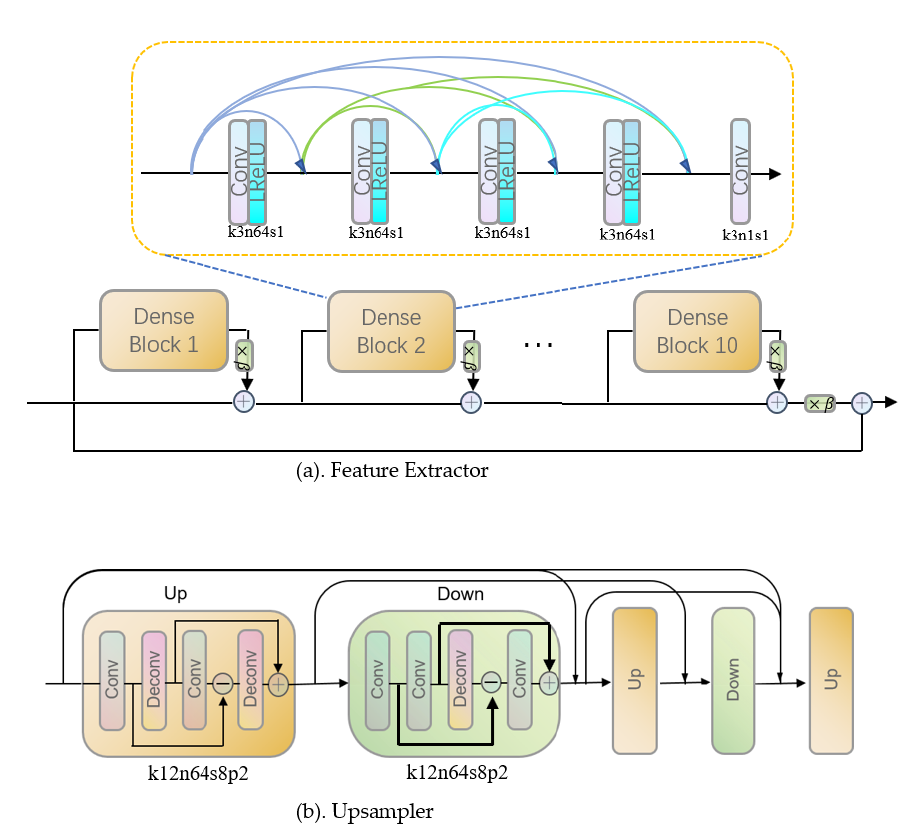
Figure 4. The architecture of the feature extractor and upsampler. Illustration of the ( a ) feature extractor and ( b ) upsampler. β is the residual scaling parameter, which is set to 0.2 k and denotes the kernel size, n represents the number of filters, s is the size of the stride, and p is the size of padding. In ( b ) the conv and deconv share the same numbers of kernel size, features, stride, and